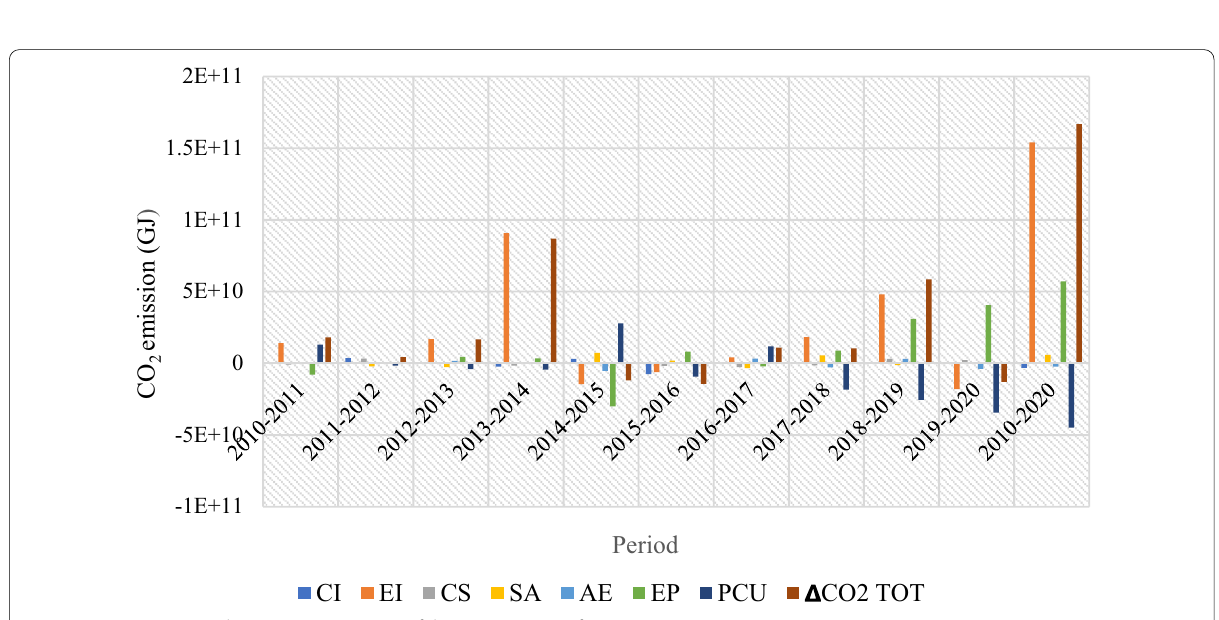
Fig. 3 CO 2 emissions and energy consumption of the Nigerian manufacturing sector